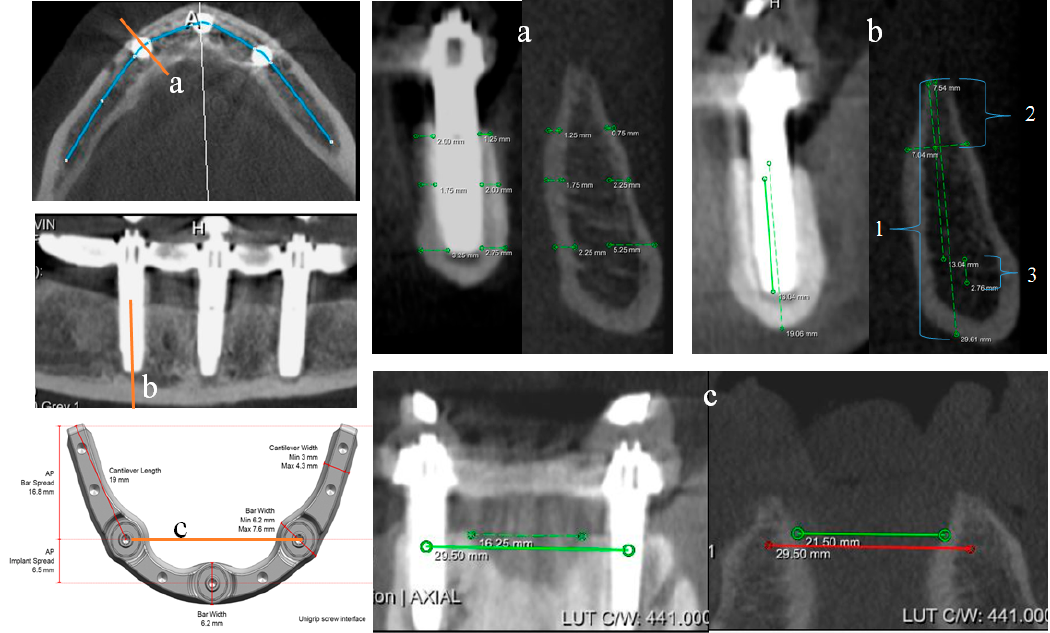
Figure 2. Measurements taken from CBCT images, on the reference model (left) and then transposed and adjusted on the test sample (right) ( a ) Buccal-lingual bone width at apex, middle and platform levels of each implant, ( b ) bone height measurements (1 = total bone height, 2 = bone resection height, 3 = distance from implant apex to incisive canal base), and ( c ) jawbone width measurements.